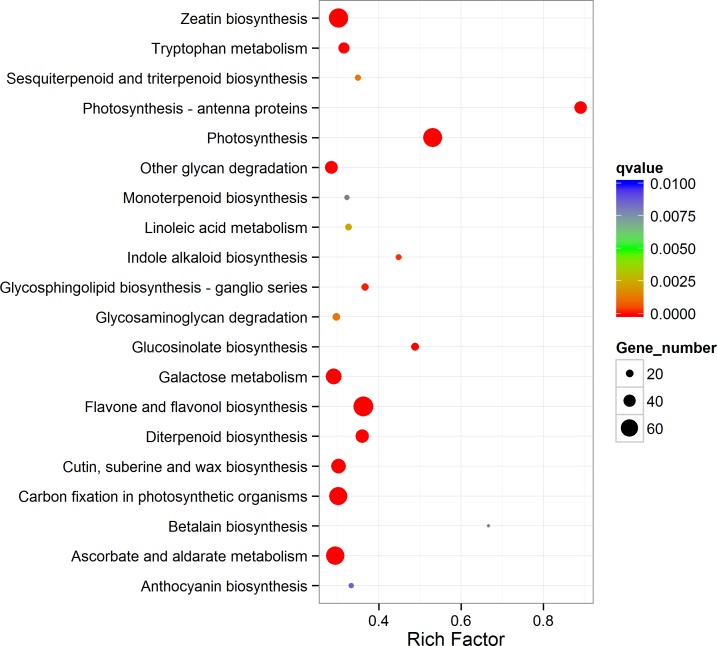
Enriched KEGG of up-regulated transcripts of the annotated DEGs.The left Y-axis indicates the KEGG pathway. The X-axis indicates the Rich factor. A high q value is represented by blue, and a low q value is represented by red. “Rich factor” in Fig 4 represents the number of up-regulated DEGs in the related pathway divided by the number of all the annotated genes in this pathway. “qvalue” is the name of the adjusted p-values obtained using an optimised False Discovery Rate (FDR) approach.